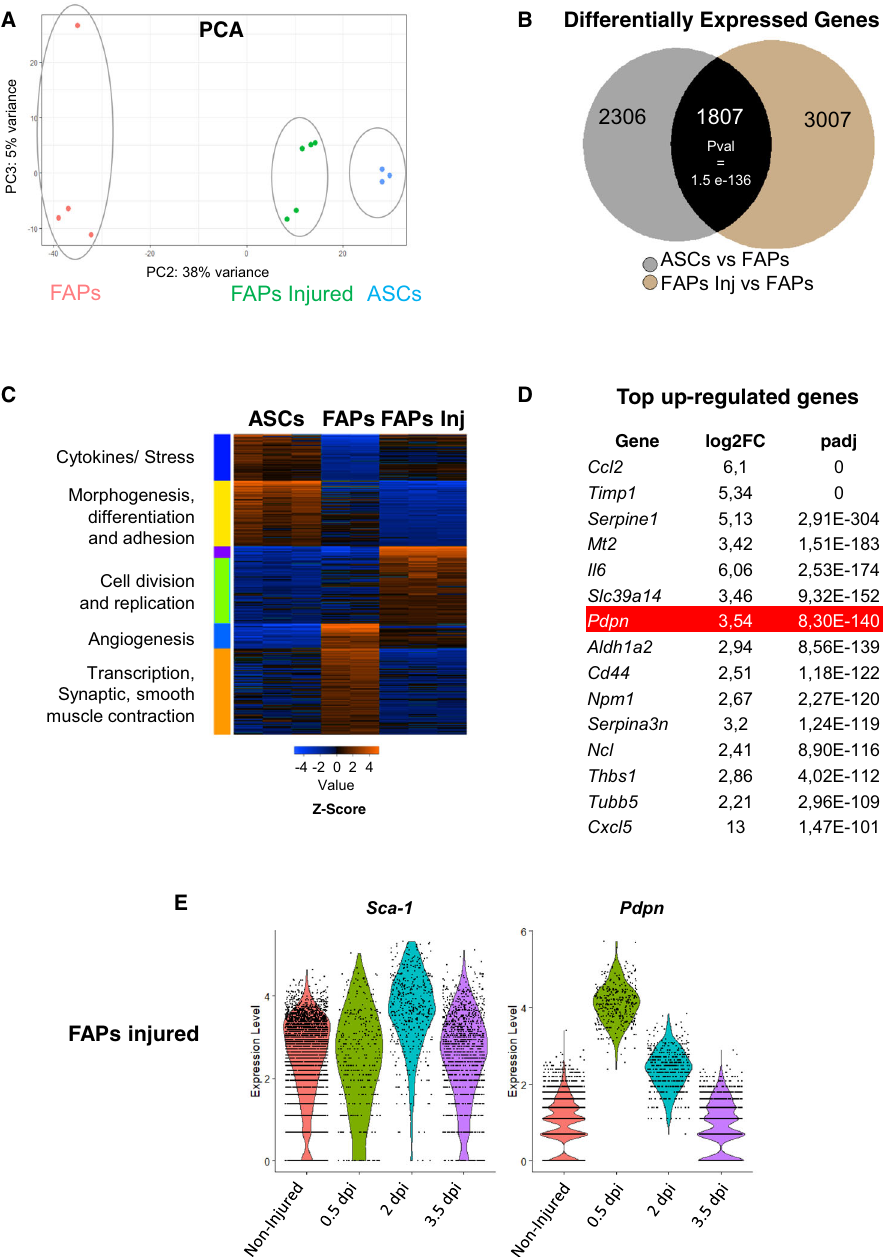
Fig. 1 | Muscle injured derived FAPs resemble ASCs from ScAT. A Principal- component analysis (PCA, PC2 vs PC3) of RNAseq expression values of FAPs and ASCs isolated from injured (1 dpi) and control animals. B Venn diagram showing overlapofdifferentiallyexpressedgenesinASCsfromScAT(SCAT)andFAPsfrom injured muscle (FAPInj) as compared with FAPs in non-injured animals (FAP). LOG2FC>0.58 and p value<0.05. C Expression heatmap of K-mean clustering of differentially expressed genes (expressed in Z score) in FAPs groups (control and